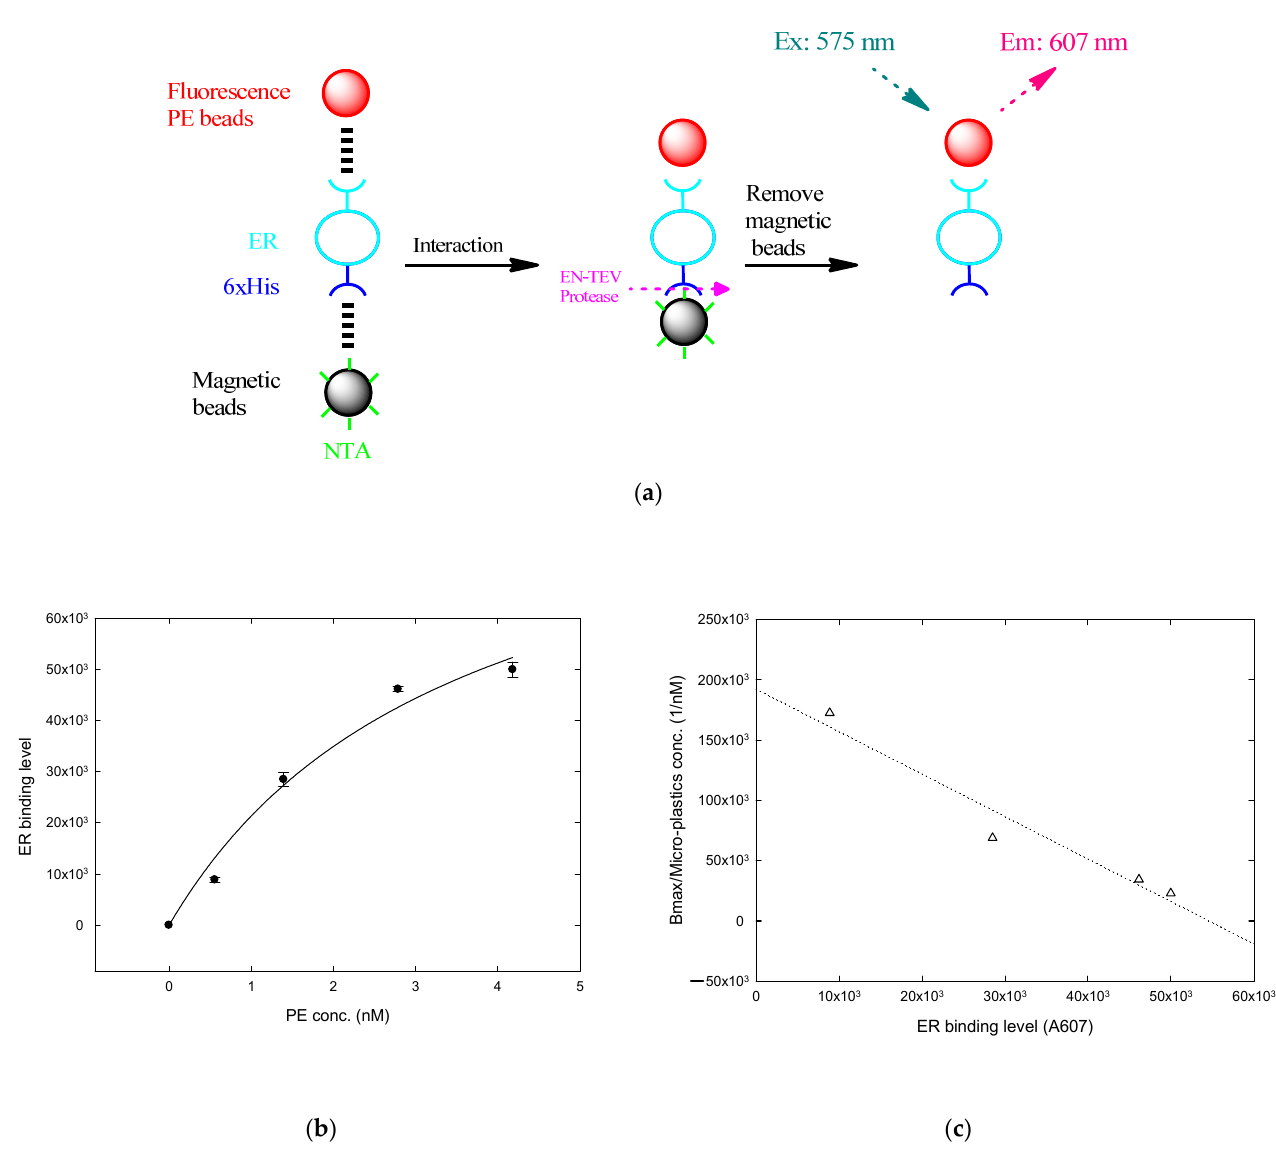
Figure 7. ELISA-like method for determining PE micro-plastics. ( a ) General procedure showing the detection process. The estrogen receptor was immobilized on magnetic beads’ surface; then, the PE-fluorescence micro-plastics were used to interact with the ER. Magnetic beads were removed after cutting with EN-PEV protease, and the difference in fluorescence values was observed (Ex/Em: 575/607 nm). ( b ) The PE micro-plastic concentration and fluorescence absorption value based on Langmuir were plotted, which indicated the relationship between PE micro-plastics and the ER binding level. ( c ) Plotted according to ( b ), the obtained ER binding level, bound amounts and micro-plastics concentration at which the dissociation constant was obtained. All data were repeated twice (( b ) was calculated with numerical averages).